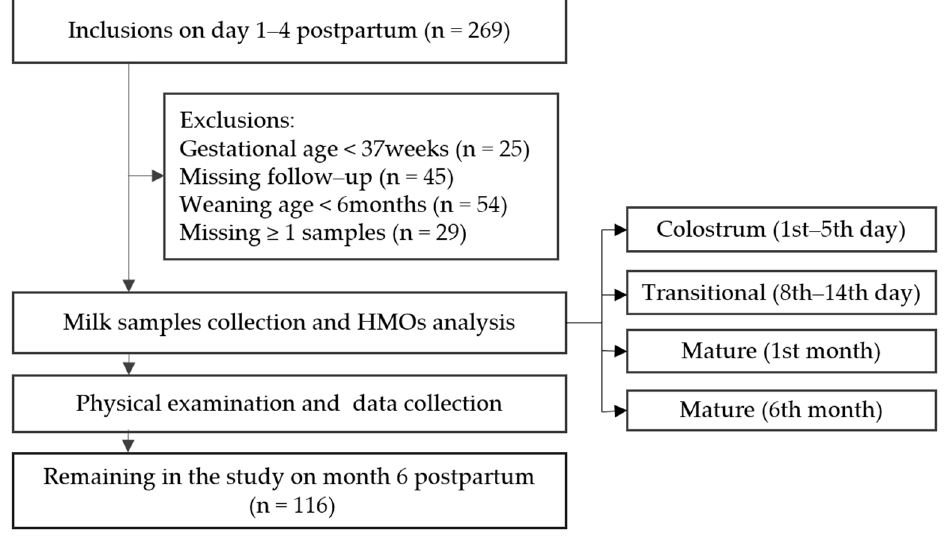
Figure 1. Flow chart of inclusions.